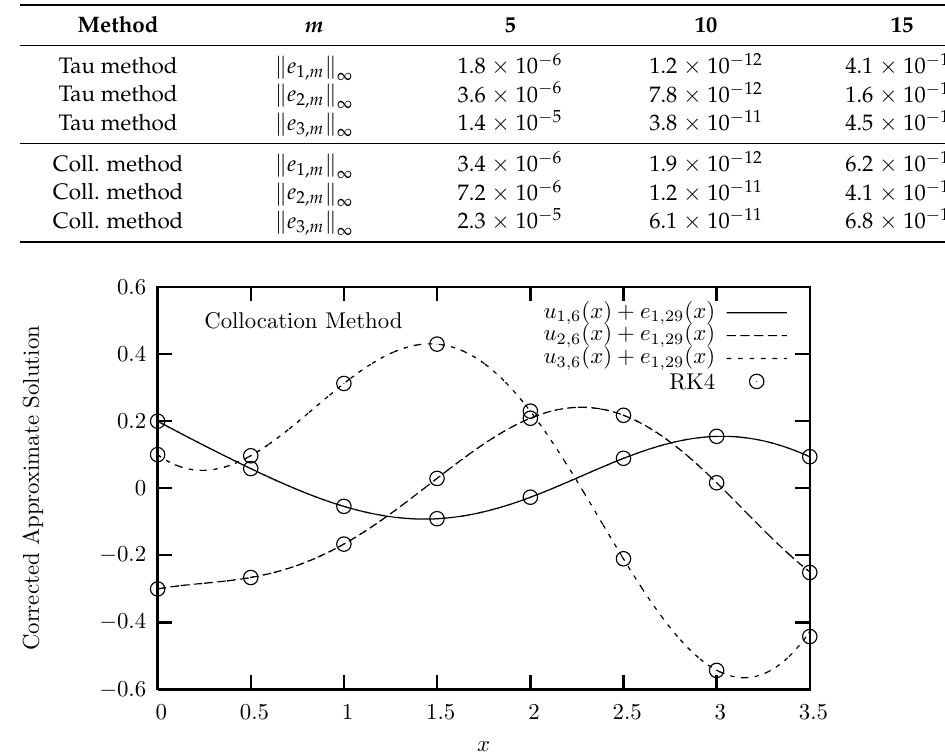
Table 4. The maximum values of the absolute errors by using the estimations of the absolute errors on the interval [ 0,1 ] for Example 3.